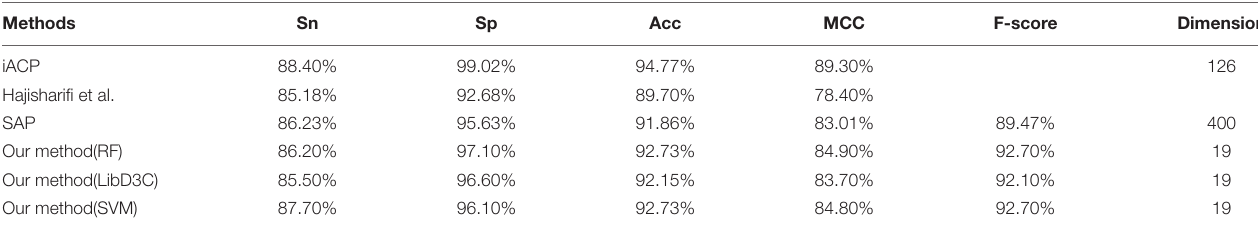
FIGURE 2 | The results of different experiments. (A) According to the results, this paper thought that the CT, GAAC, GDPC, GTPC, and TPC are not ideal. (B) According to the results, this paper thought that the greedy algorithm was more efficient than MRMD2.0. (C) According to the results, this paper thought that the greedy algorithm is worse than MRMD2.0 in the performance index of the selected model. (D) After several dimension reductions, the results showed that the MRMD2.0 was better than the greedy algorithm index of the selected model. (E) After several dimension reductions, the results showed that the dimension of model of the greedy algorithm is about five times that of the MRMD2.0. The results showed that as for the dimensions of the selected model, the greedy algorithm was more efficient than MRMD2.0. However, the greedy algorithm cannot further reduce the dimensions of the selected feature model, but MRMD2.0 can still further reduce it. TABLE 1 | Comparing the performance of different